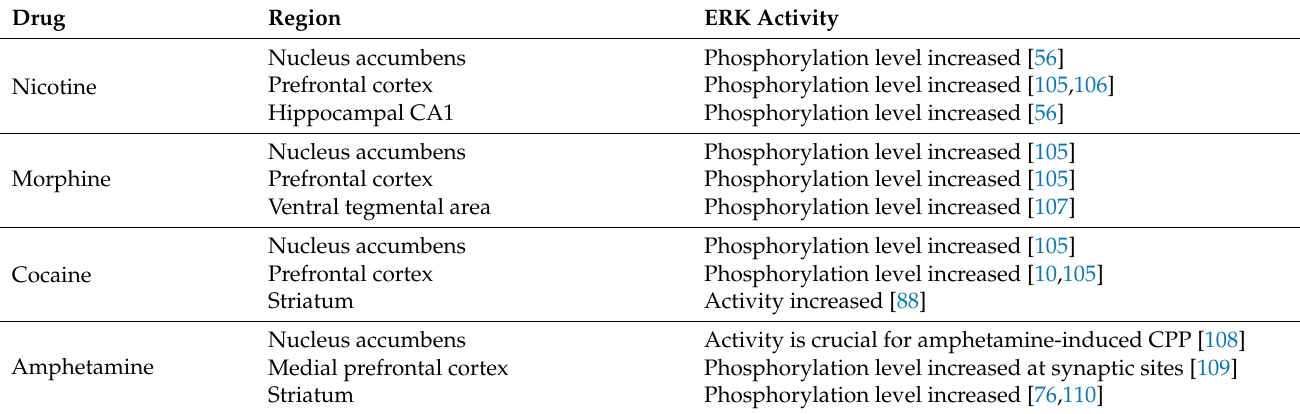
Table 2. Evidence that ERK activity is fully involved in the circuitry of brain regions for various drugs of abuse. Drug